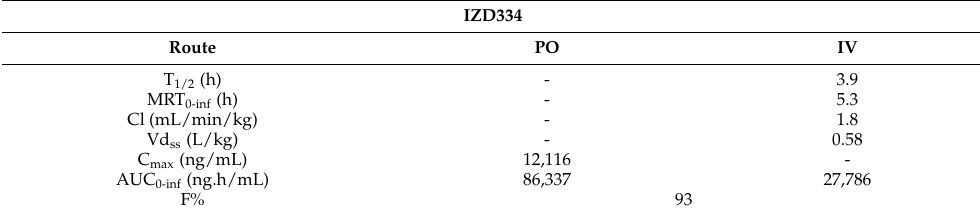
Table A1. Histological analysis and myocardial IL-1 β measurement.